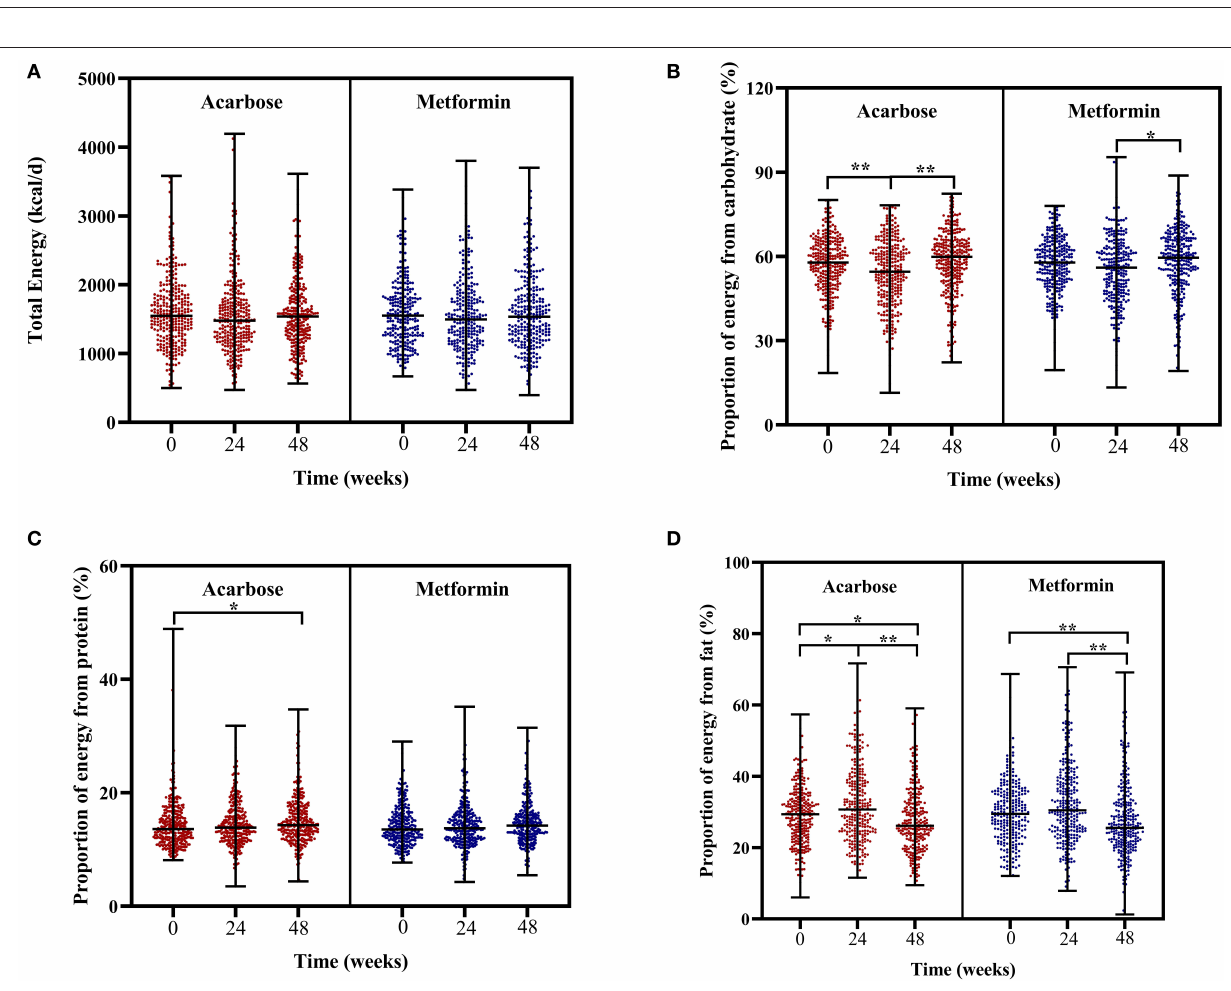
FIGURE 3 | Scatter plots of total energy intake (A) , proportion of energy from carbohydrate (B) , proportion of energy from protein (C) , and proportion of energy from fat (D) in patients subjected to metformin or acarbose groups at baseline, 24 weeks, and 48 weeks. Data were tested by Friedman’s two-way analysis of variance by ranks test during three time periods (i.e., baseline, 24 weeks, and 48 weeks) in two treatment groups. * post-hoc pairwise comparison adjusted P < 0.05, ** post-hoc pairwise comparison adjusted P < 0.01.